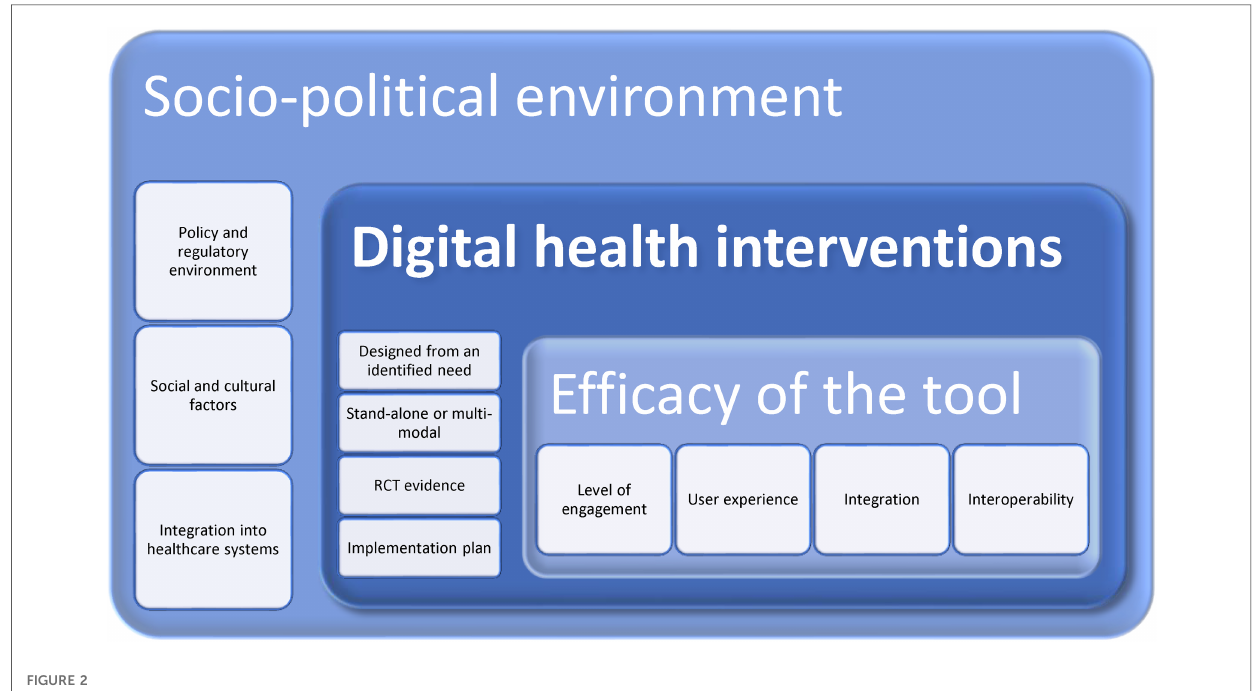
FIGURE 2 A systemic framework to consider digital health